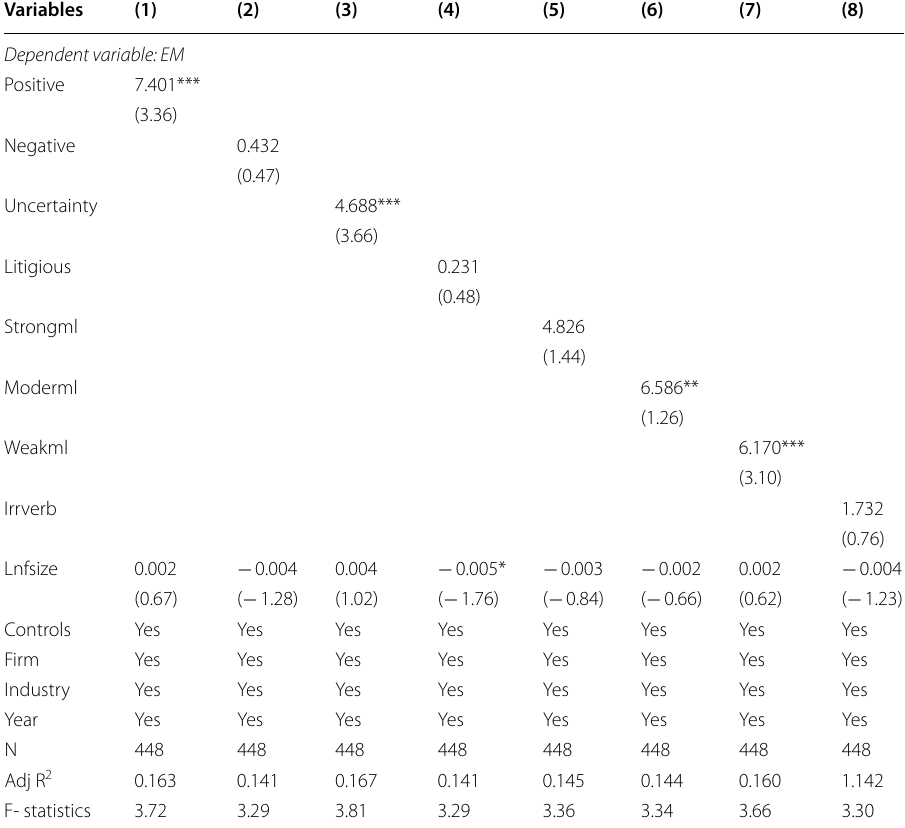
Table 6 Regressions after controlling for the length of financial